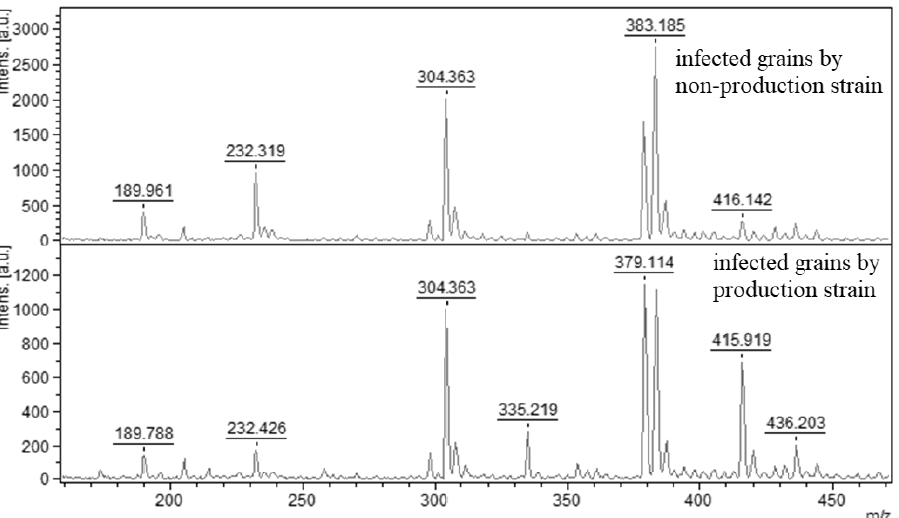
Figure 5. MALDI-TOF mass spectra of AFB 1 isolated directly from wheat and barley grains infected by producing strain (335.219 m/z) and non-producing strain of A. flavus (AFB 1 peak